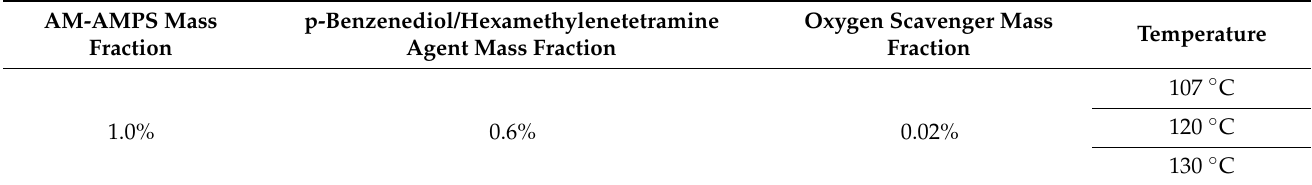
Table 6. Scheme of the temperature optimization experiment.